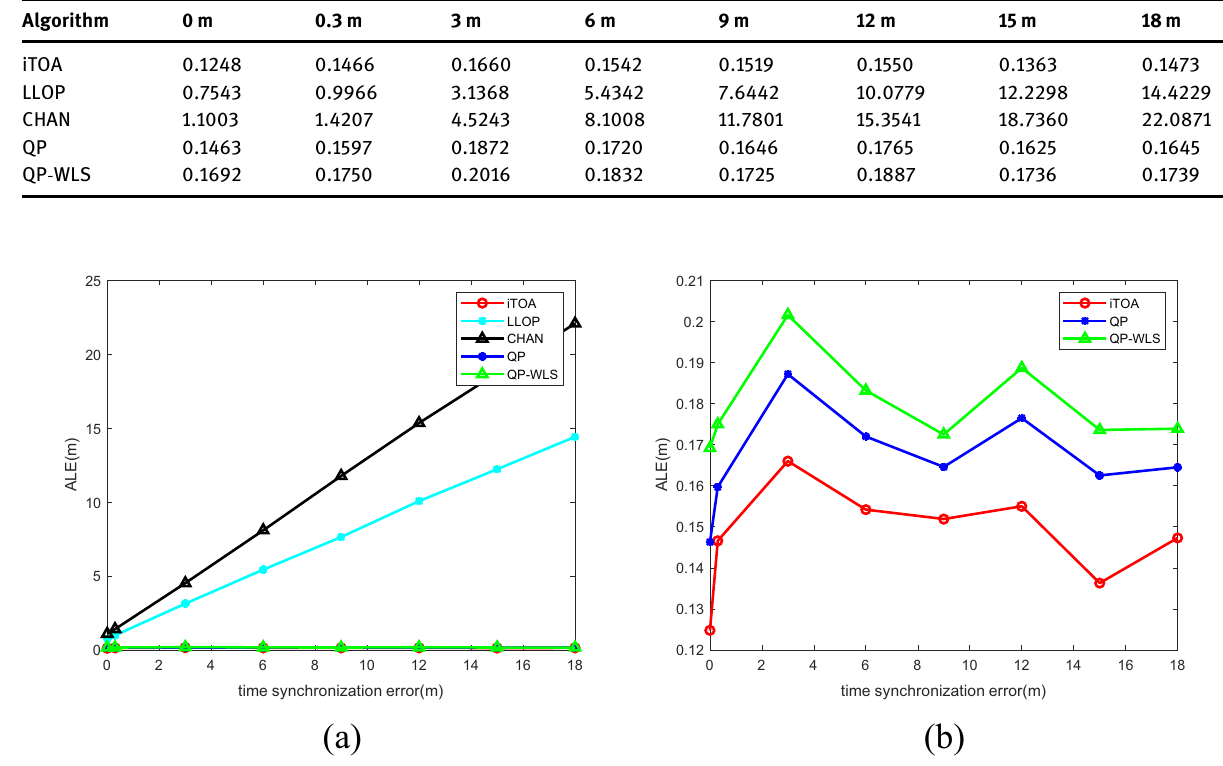
Figure 2: ALE of di ff erent time synchronization errors of fi ve algorithms when the NLOS error value is fi xed at 2m. ( a ) ALE diagram of fi ve algorithms and ( b ) ALE diagram of three